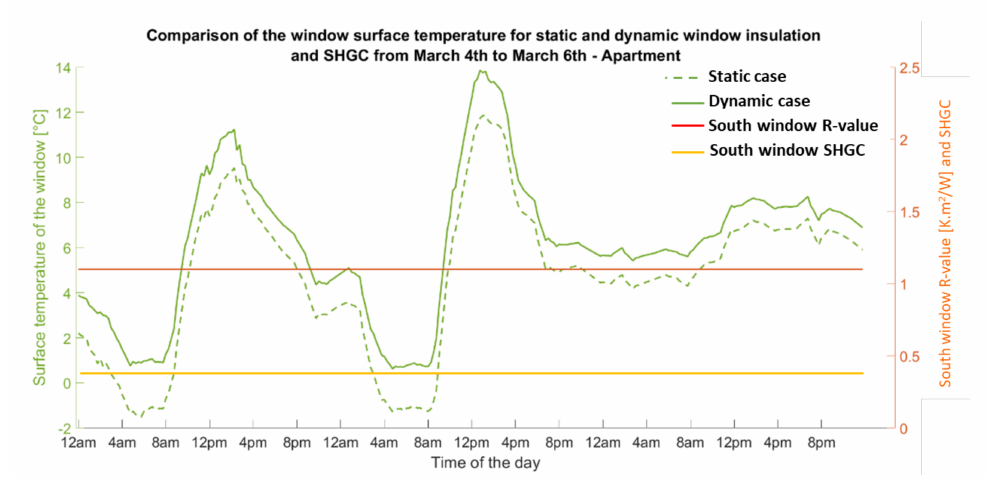
Figure 9. Exterior surface temperature of the south wall for static and dynamic window during 4 March to 6 March for the prototypical apartment unit. For dynamic windows, high R-value = 1.1 m 2 · K/W; low R-value = 0.45 m 2 · K/W; high SHGC = 0.4; low SHGC = 0.1. For static windows, R-value = 0.45 m 2 · K/W; SHGC =